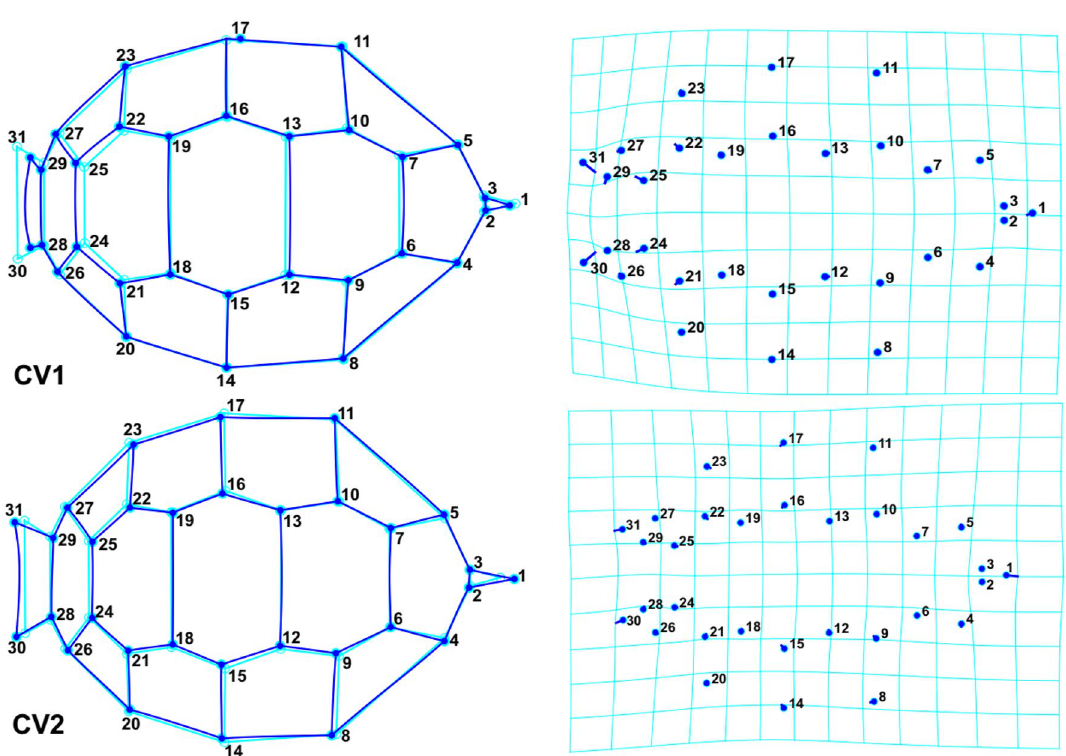
Figure 8. Carapace shape variation of T. graeca populations defined by transformation grids (right) and wireframe graphs (left) of the first two canonical axes in Central